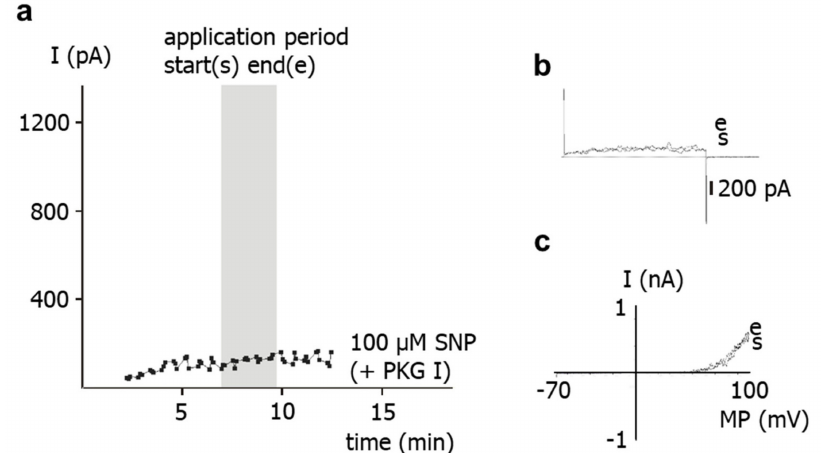
Figure 3. Effect of the NO-donor SNP on the outward current of rat tail artery smooth muscle cells in the presence of the PKG-inhibitor Rp-8-Br-PET-cGMPS. ( a ) Example of the time course of the effect of SNP in the presence of 1 µ M Rp-8-Br-PET-cGMPS (PKG I) on the outward current. The application period is shown as grey area; start of application is marked as (s), end of application as (e). The current was elicited with use of a 500 ms-long voltage step from a holding potential of − 40 mV to a test potential of +70 mV. ( b ) Examples of traces of the outward current elicited with use of a 500 ms-long voltage step from a holding potential of − 40 mV to a test potential of +70 mV at the start (s) and at the end (e) of the application of SNP in the presence of 1 µ M Rp-8-Br-PET- cGMPS. ( c ) Examples of current–voltage (I–MP) relationships of outward current elicited with use of a 1.5 s-long voltage ramp from a holding potential of − 40 mV in the voltage range from − 70 to +100 mV at the start (s) and at the end (e) of the application of SNP in the presence of 1 µ M